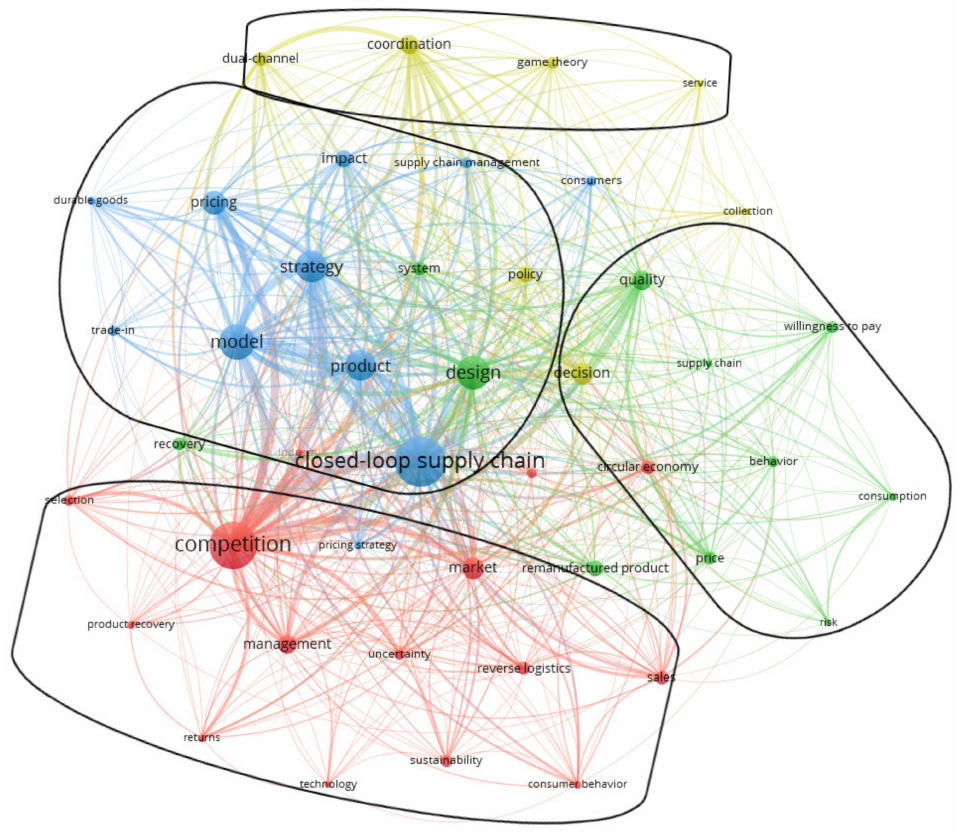
Figure 5. The network visualization map of 45 high-frequency